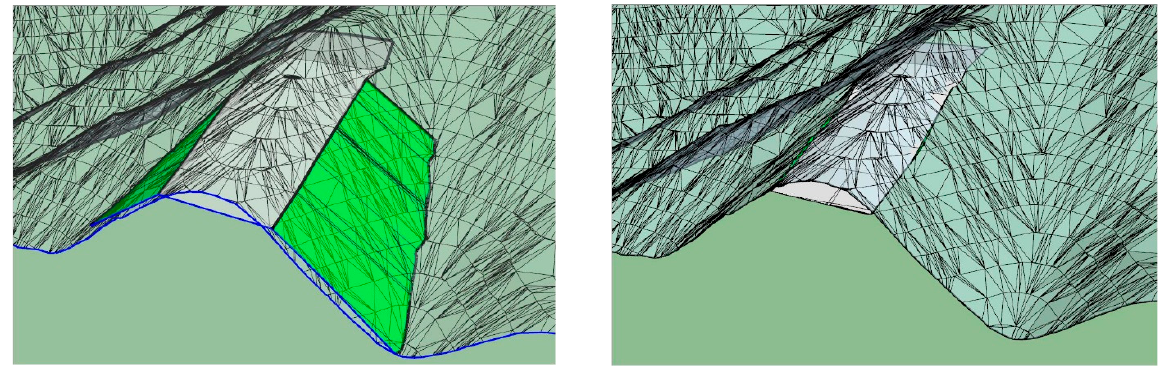
Figure 14. The comparison before and after optimization through 3D visualization.